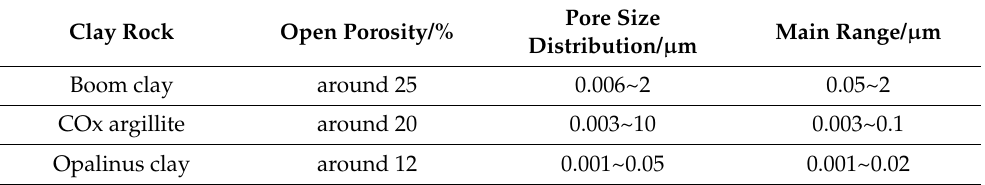
Table 1. Pore structure characteristics of the investigated clay rocks. Clay